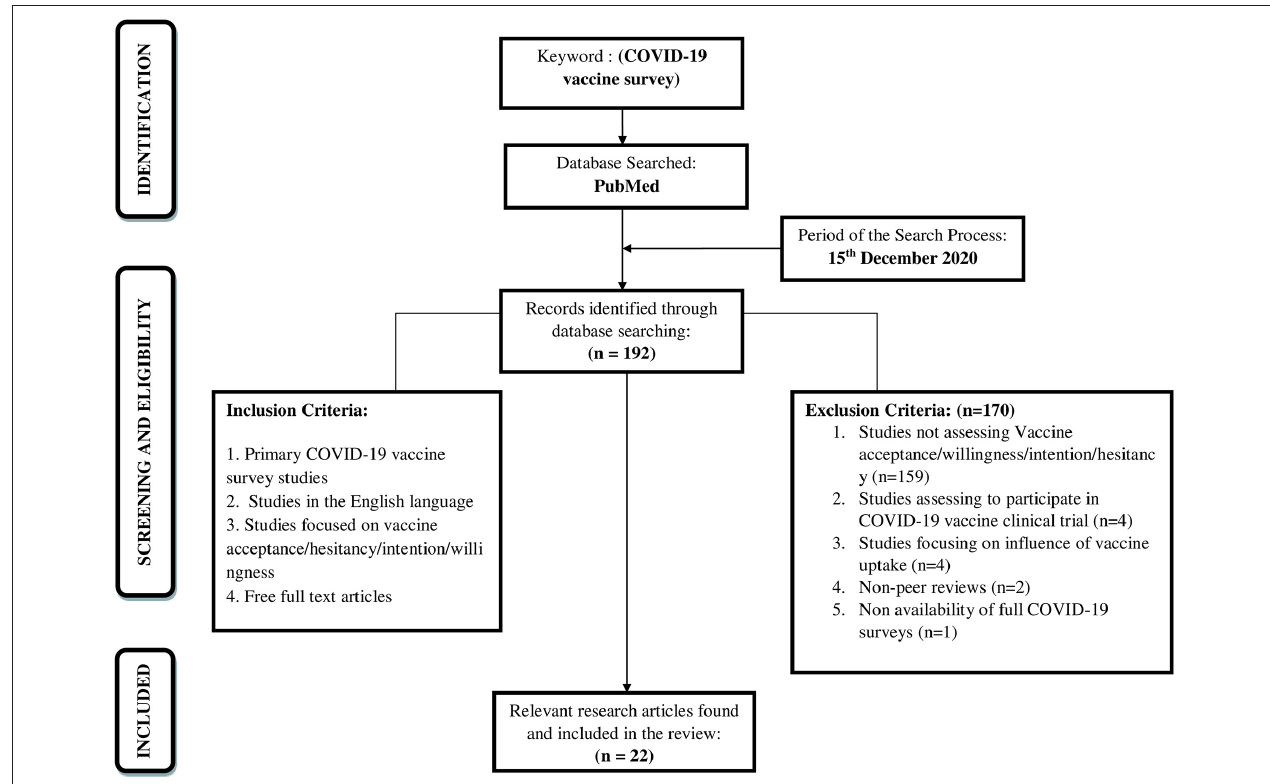
FIGURE 1 | Flowchart of the search strategy and the study